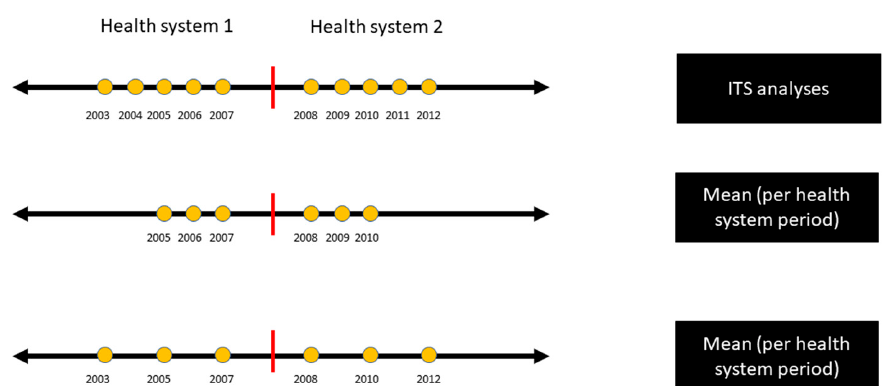
Figure 2. Analysis strategies subject to the availability of the data points for each variable. ITS = interrupted time-series.